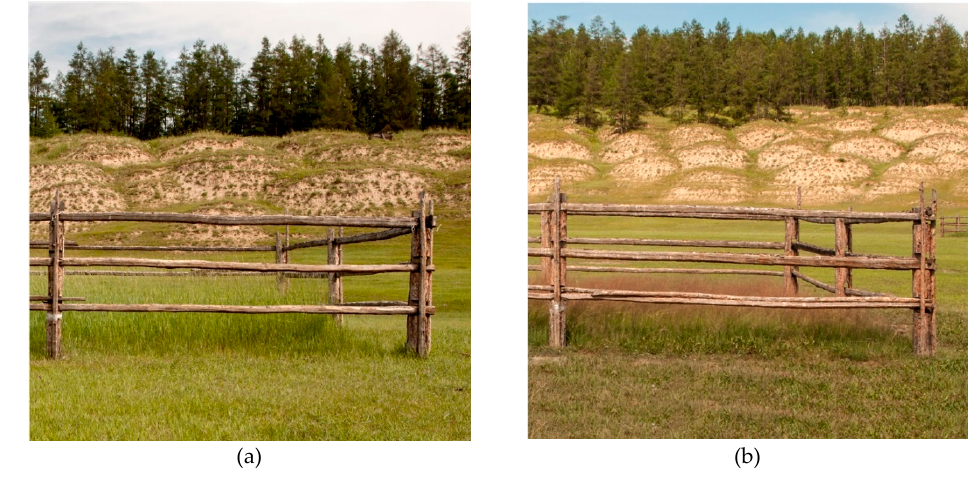
Figure 3. Photos of the experimental sites of the upper ( a ) and middle ( b ) zones of